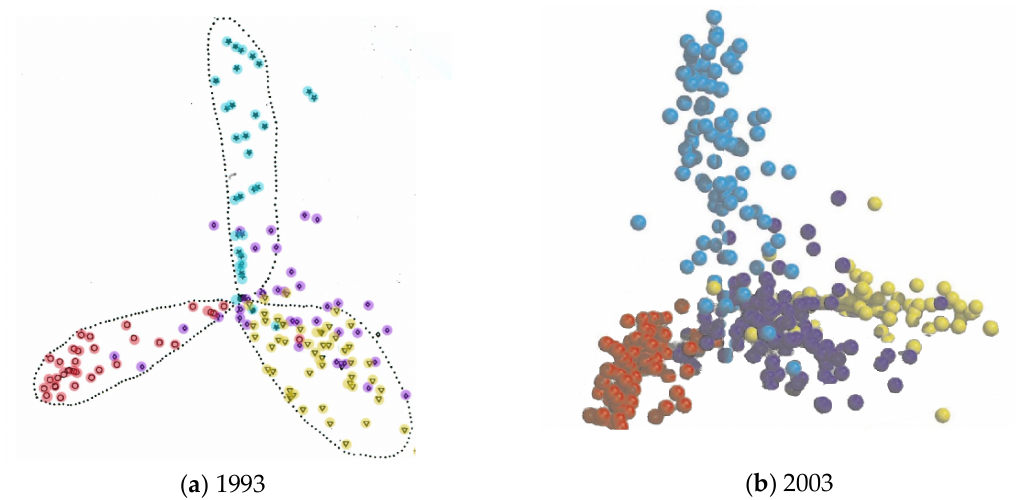
Figure 2. Protein fold-space projections. The distances among known structures are visualised by projection into Euclidean space. The structures (dots) are coloured according to structural class: red = alpha, yellow = beta, blue = alpha / beta and purple = alpha + beta. (The latter being a smaller less well-defined class). ( a ) As seen by Orengo et al. (1993) [14] and ( b ) as seen by Hou et al. (2003) [16]. Note the overall structure has remained unchanged over ten years.